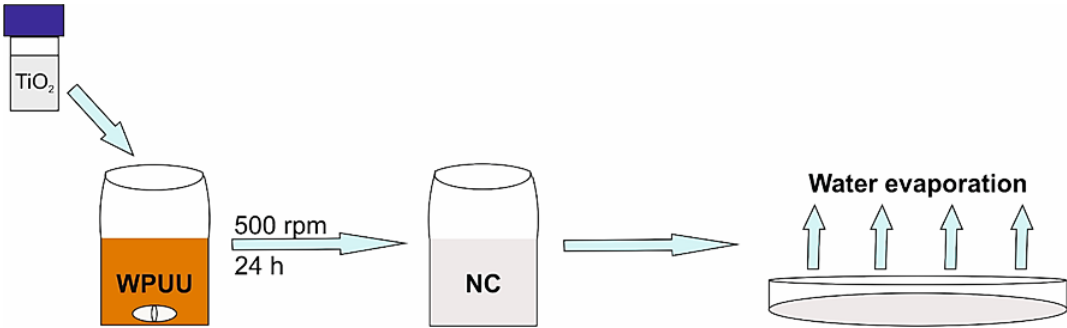
Figure 1. Schematic description of the procedure for the preparation of the nanocomposites (NCs). WPUU = waterborne poly(urethane-urea).